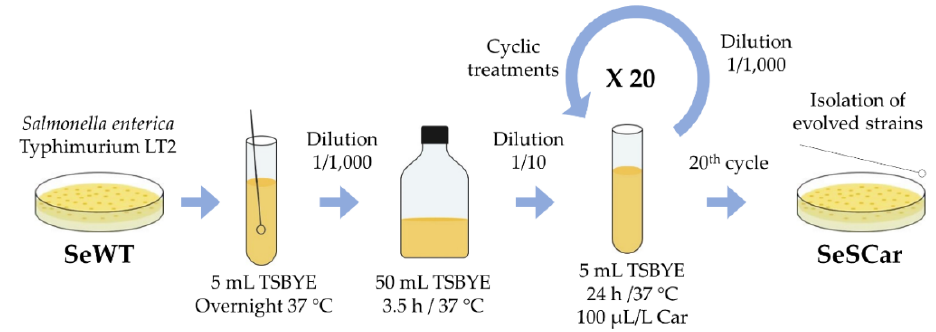
Figure 2. Diagram of evolution assay by prolonged sublethal treatments.